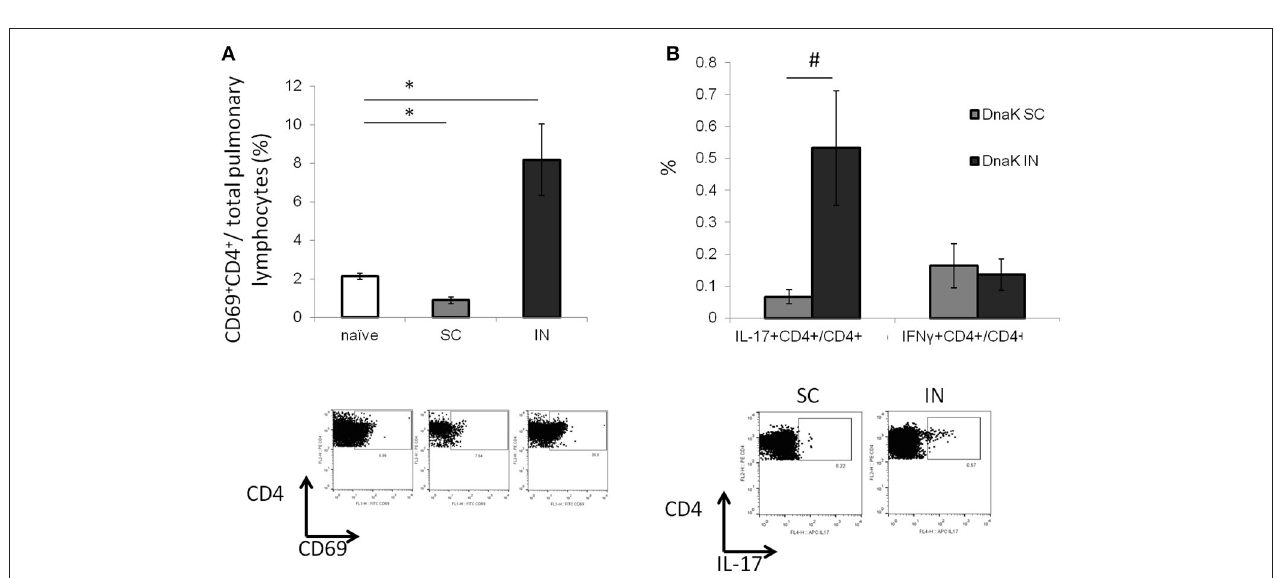
FIGURE 2 | Intranasal vaccination with recombinant DnaK protein generates IL-17-secreting CD4 + T cells in the lungs. C57BL/6J mice were vaccinated twice with DnaK (100 µ g) by subcutaneous injection or DnaK (20 µ g) by intranasal injection. Parenchymal intrapulmonary T cells were analyzed 2 weeks after the last vaccine dose. (A) After tissue digestion, unstimulated intrapulmonary CD69 + CD4 + T cells were measured by flow cytometry. N = 3–4, * p < 0.05 compared to compared to the other two groups. (B) Intrapulmonary T cells were stimulated with recombinant DnaK (10 µ g/ml) and antigen-specific CD4 + T cells were evaluated for IFN γ and IL-17 secretion by intracellular cytokine staining. Mean ± SEM, N = 3–4, # p < 0.05 compared to SC-vaccinated